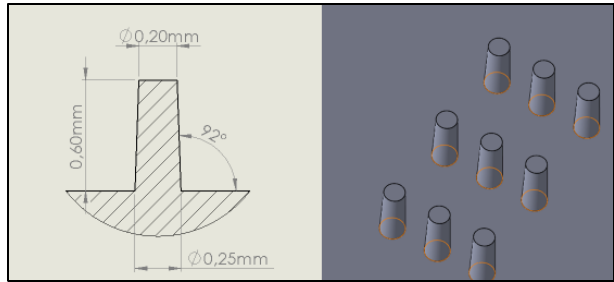
Figure 2. The micro pillars’ feature shape and the dimensions of the parts.